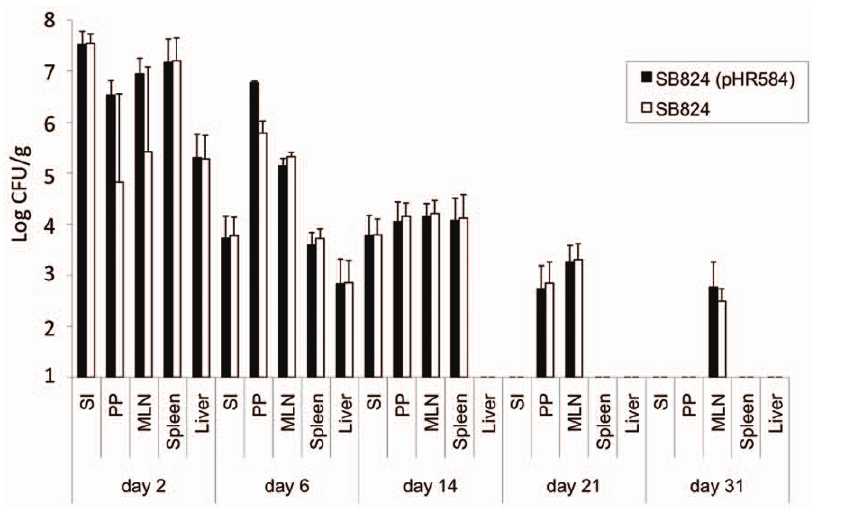
Figure 2. Colonization kinetics in different organs after oral vaccination with Salmonella SB824 (pHR584) or SB824. Small intestines (SI), Peyer’s Patches (PP), mesenteric lymph nodes (MLN), spleens and livers of five mice were analyzed for the amount of Salmonella (determined as colony-forming units per gram tissue; CFU/g) on days 2, 6, 14, 21 and 31 post immunization. Each experiment was performed at least twice with similar results.